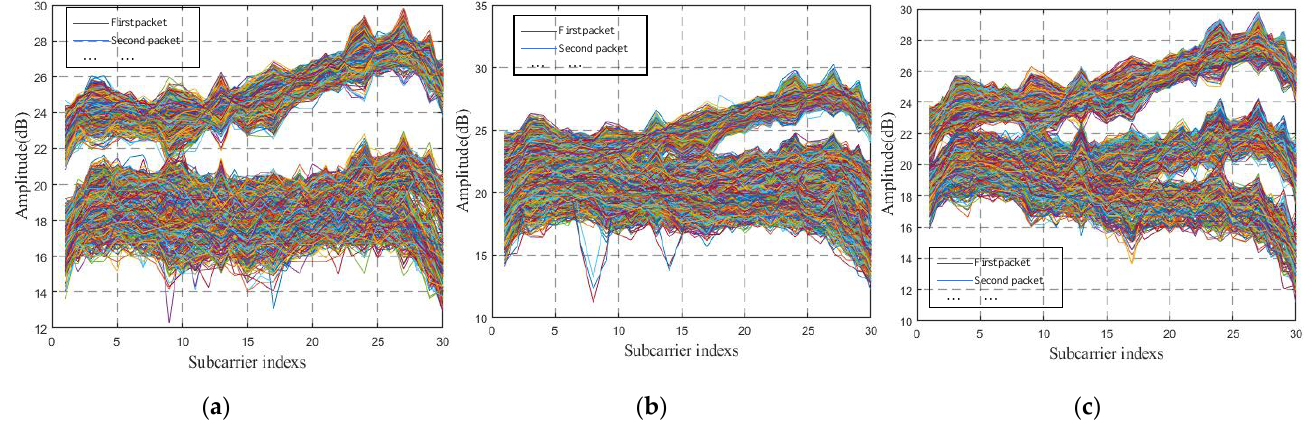
Figure 9. Original CSI signals of different people doing POSE THREE in Figure 1. ( a ) Experimenter A-POSE THREE; ( b ) experimenter B-POSE THREE; ( c ) experimenter C-POSE THREE.